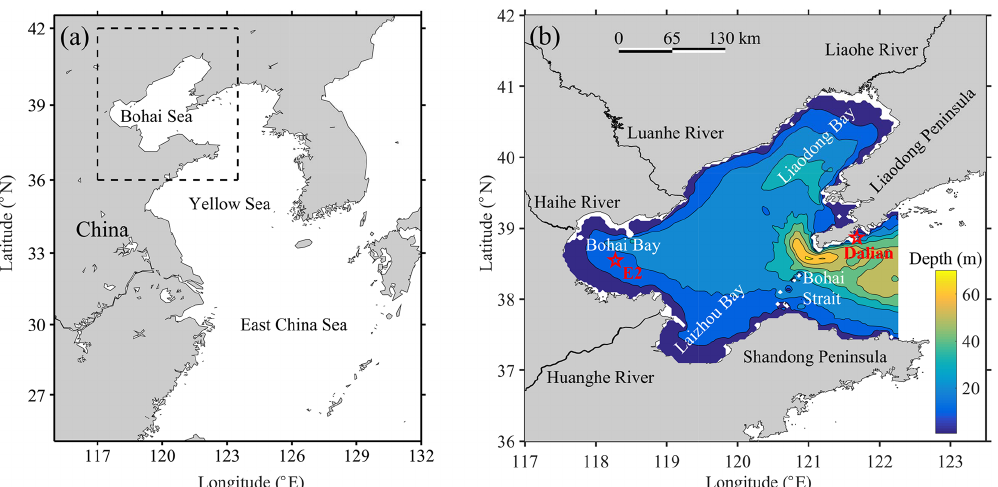
Figure 1. (a) General location of the Bohai Sea (rectangle with dashed lines); (b) locations of the observation stations (red stars), E2 and Dalian, in the Bohai Sea, and bathymetry of the Bohai Sea (colours).